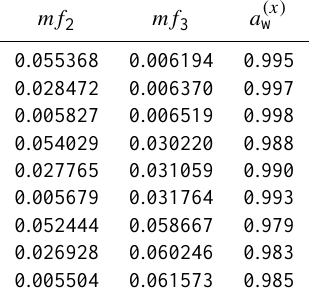
Table A8. Bulk water activity measurements of the system water